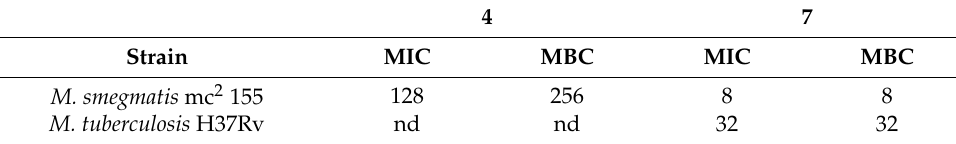
Table 4. Antibacterial activity of 4 and 7 against M. smegmatis and M. tuberculosis ( µ g/mL). nd— not